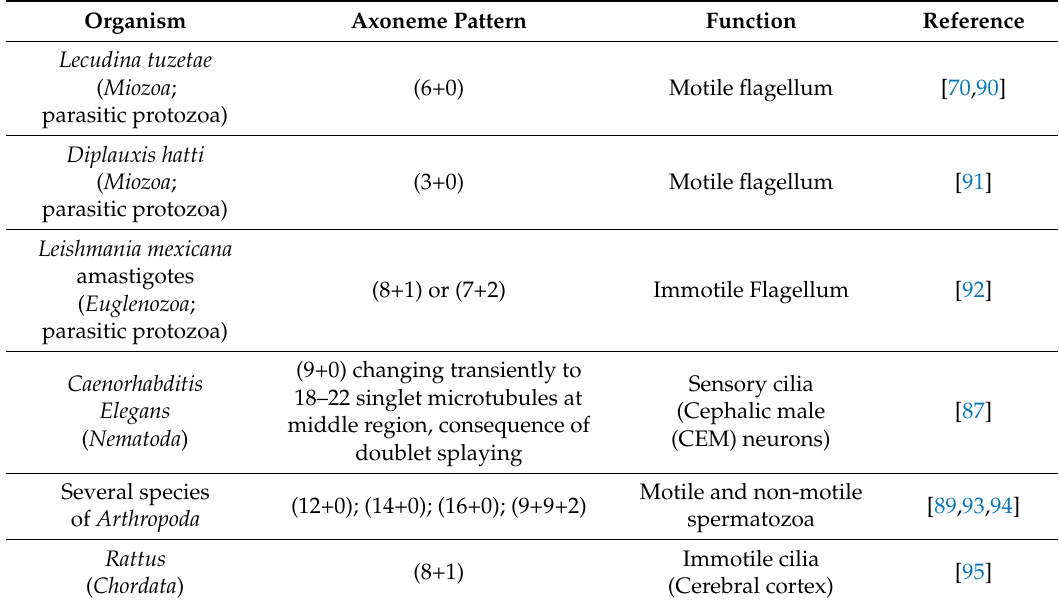
Table 1. Examples of variations to the (9+2) and (9+0) axoneme